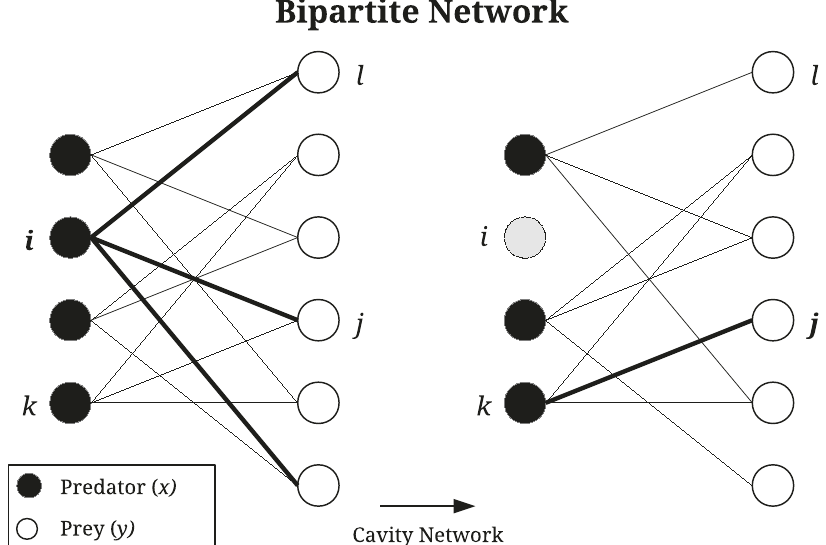
Fig. 6 Example of a bipartite predator – prey network. Here we have n x = 4 predators with c x = 3 prey each, and n y = 6 prey with c y = 2 predators each. The bold lines illustrate the connections to the focal node before and after removing a node from the network. Predator nodes (black) only have local contributions from prey nodes (white) and vice versa. In the mean- fi eld approximation for the power spectral density, these contributions are replaced by the average of each